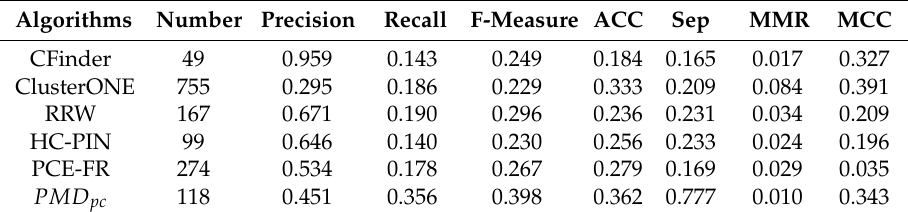
Table 1. Results of six protein complexes Algorithms in HPRD Dataset.